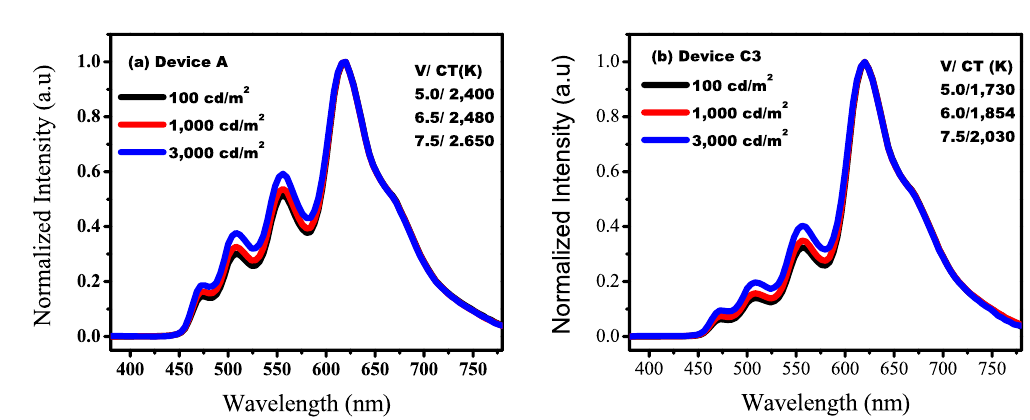
Figure 5. ( a , b ) Electroluminescent spectra of the studied wet-processed low color temperature OLED Device A and Device C3 at luminance of 100, 1,000 and 3,000 cd/m 2